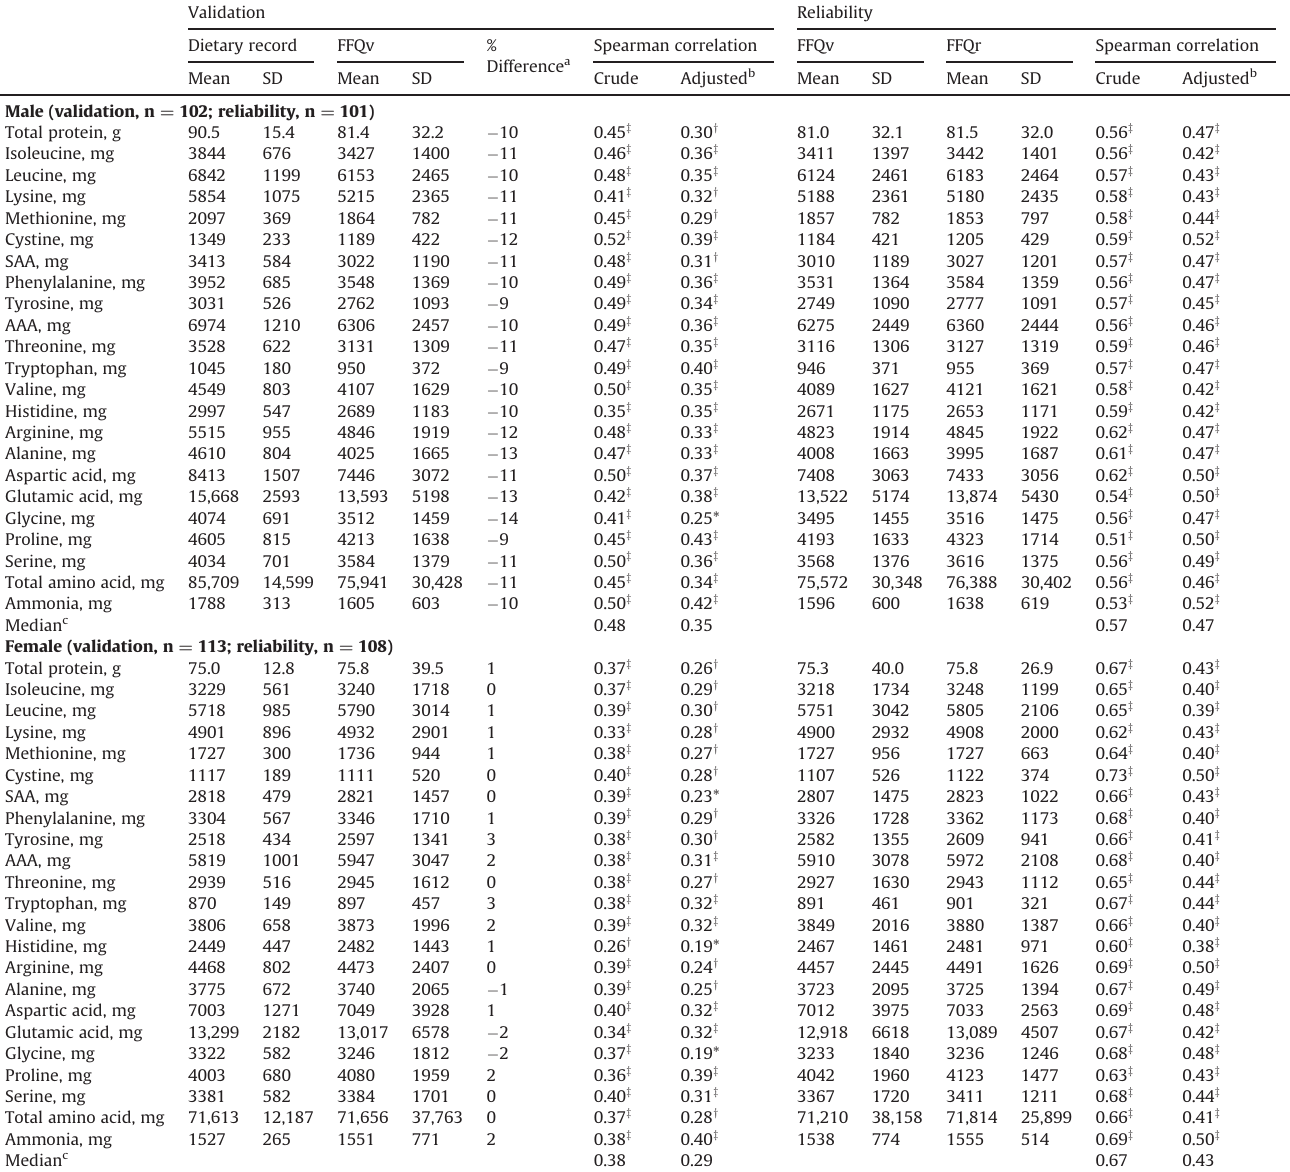
Table 1 Amino acid intakes calculated using dietary record for 28 days (or 14 days in Chubu) and food frequency questionnaires in Cohort I and their correlations. Validation Dietary